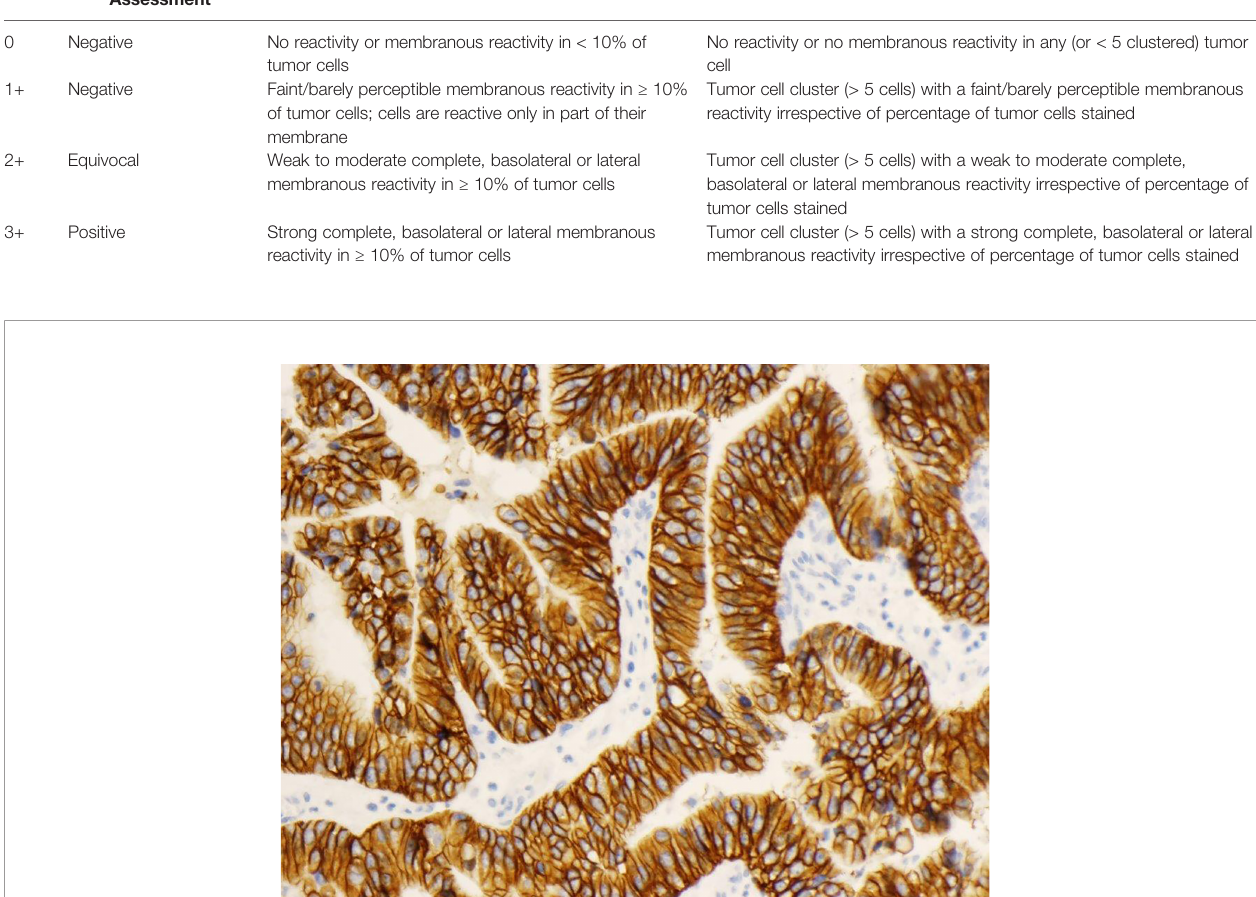
TABLE 2 | The FDA approved scoring criteria for HercepTest ™ in gastric or gastroesophageal junction adenocarcinoma (17). Score HER2 Overexpression Assessment